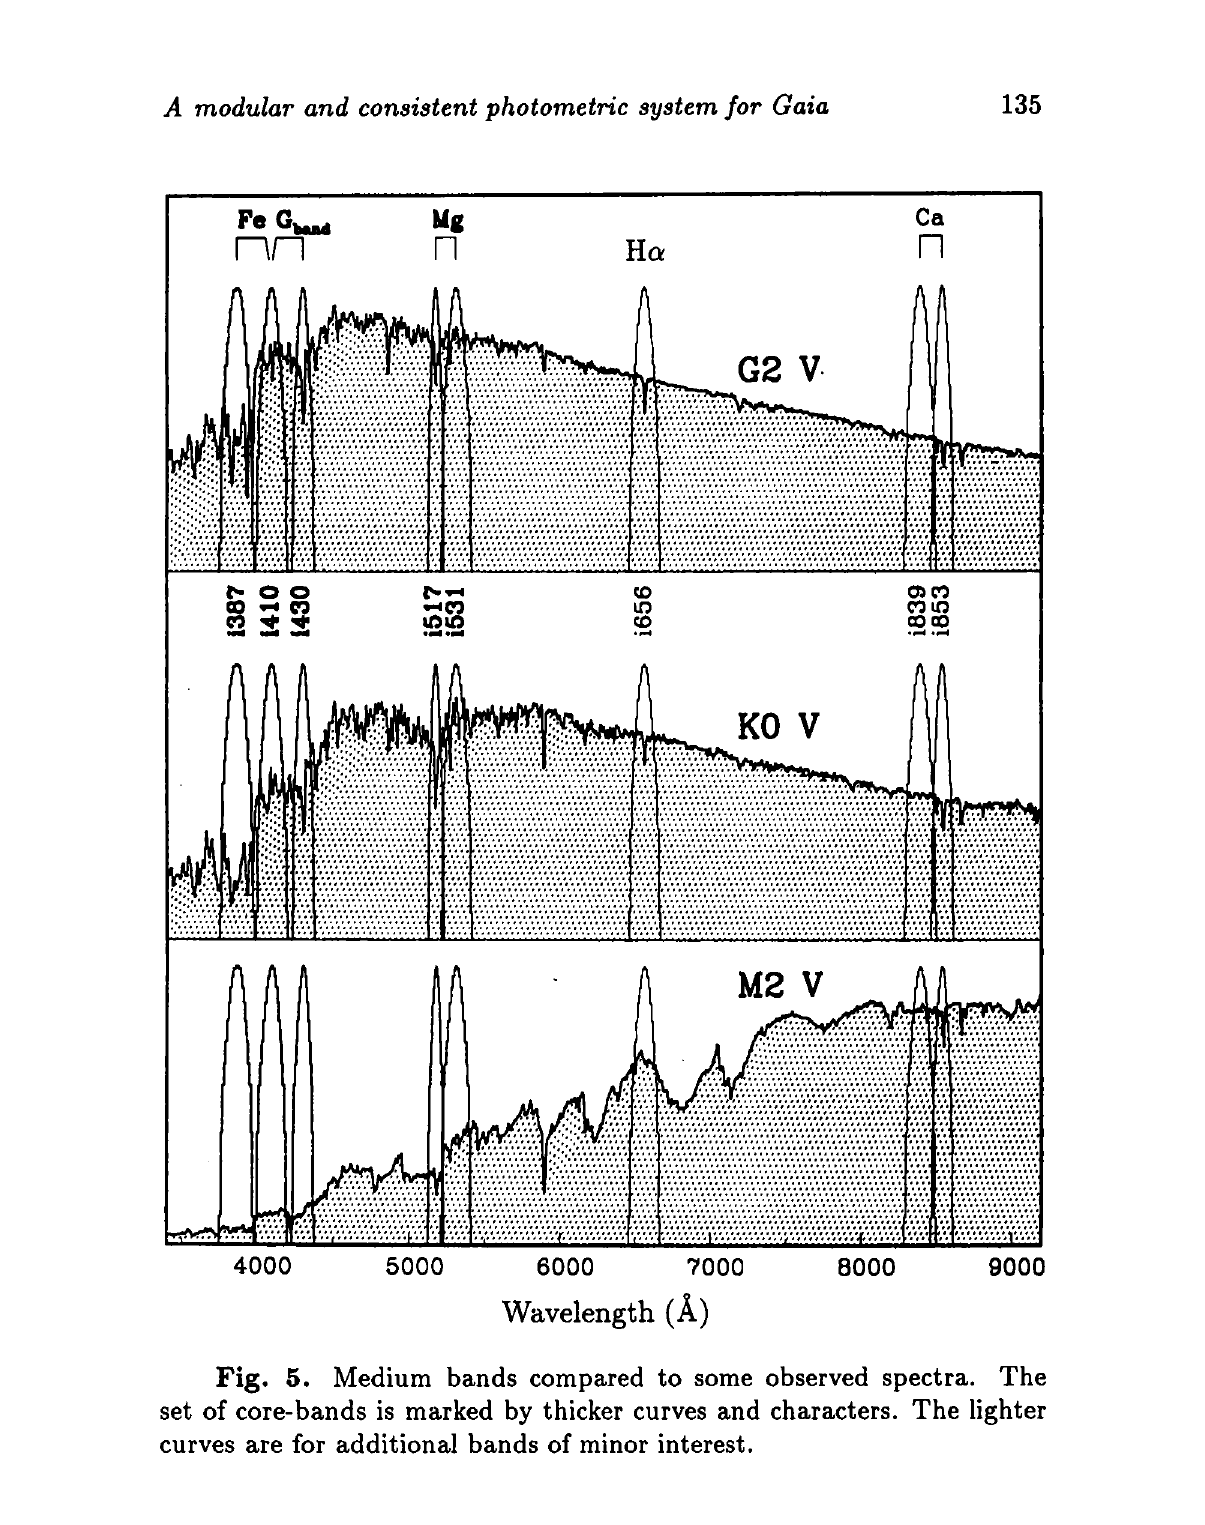
Fig. 5. Medium bands compared to some observed spectra. The set of core-bands is marked by thicker curves and characters. The lighter curves are for additional bands of minor